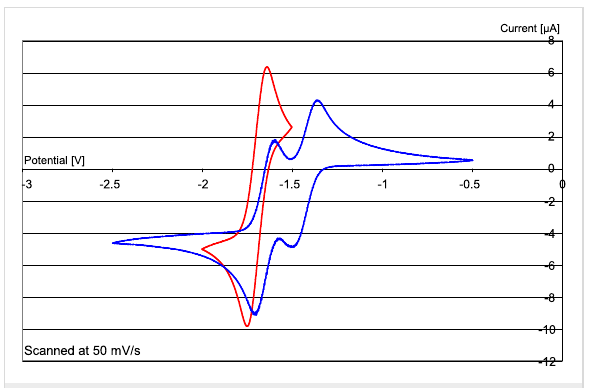
Figure 3: Cyclic voltammograms vs Fc/Fc + of 17 ′ ↔ 8 (red) and 16 ′ ↔ 14 (blue).